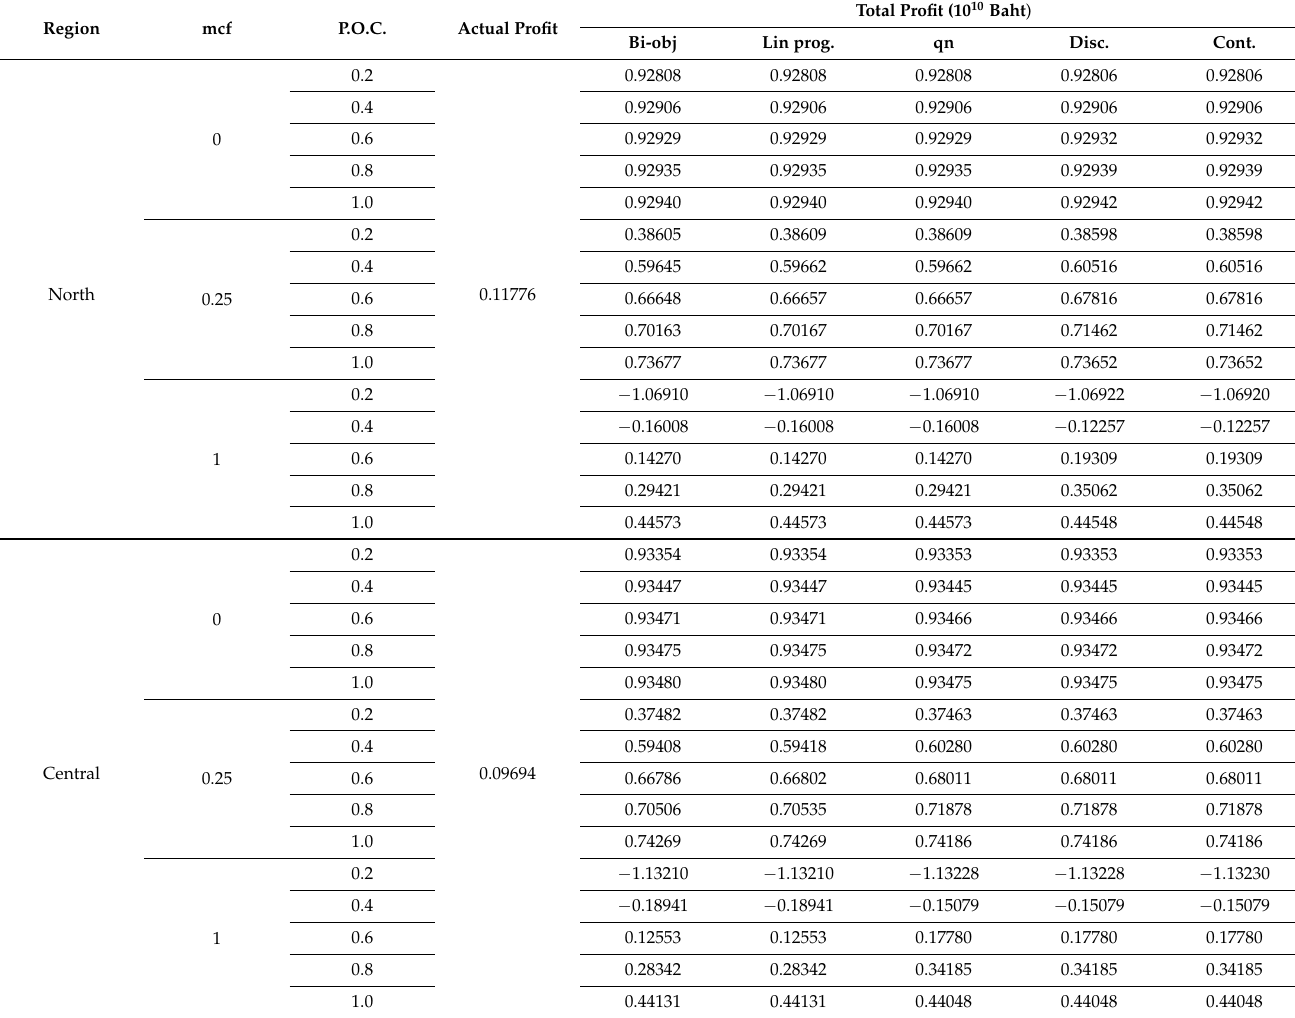
Table 7. The total profit ( × 10 10 Baht) of fresh sugarcane in each region in crop year